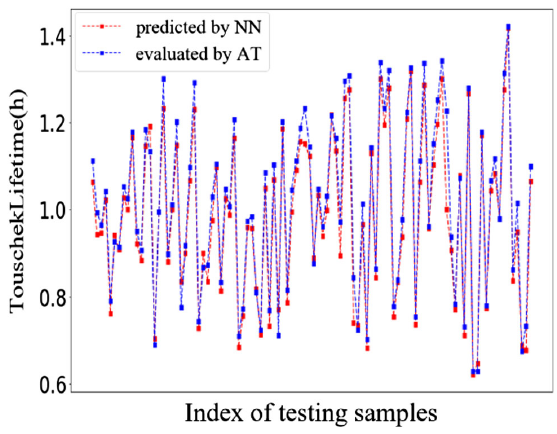
FIG. 9. Comparison of the Touschek lifetimes of 100 testing samples predicted by neural network (red) and particle tracking (blue). The coefficient of determination, R 2 , is